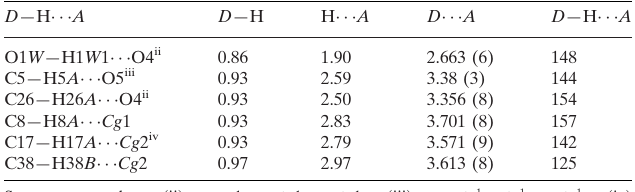
Hydrogen-bond geometry (A˚ , (cid:5)